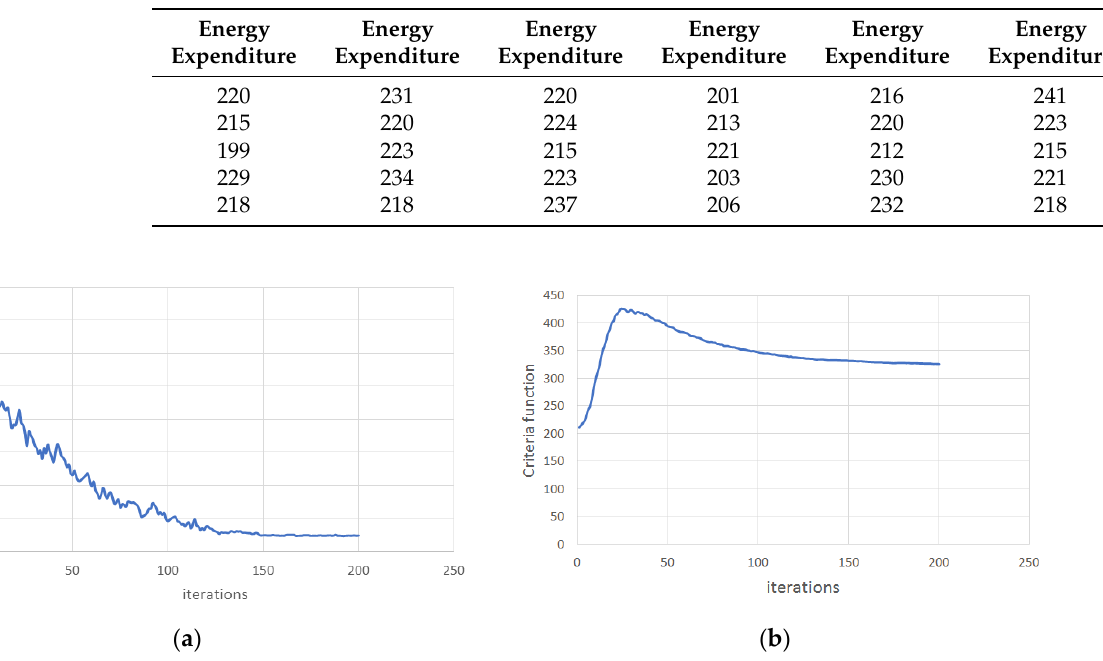
Figure 6. Operation of the genetic algorithm, ( a ) test settings 4, ( b ) test settings 3.